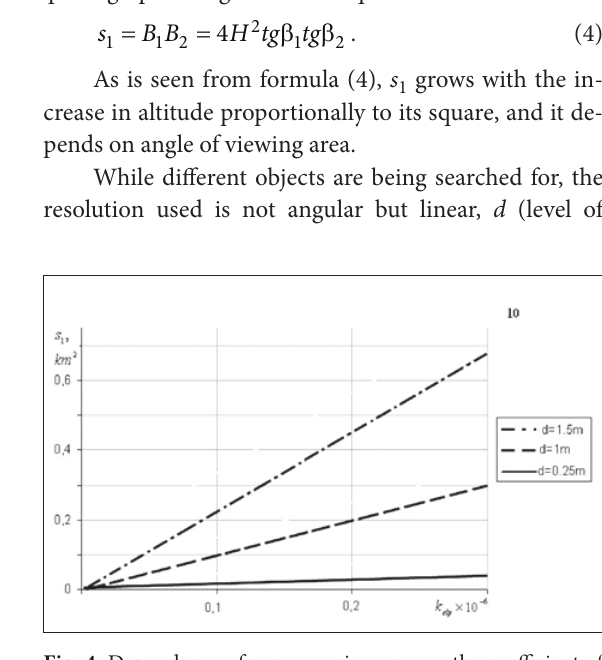
Fig. 4. Dependence of survey region area on the coefficient of the optical